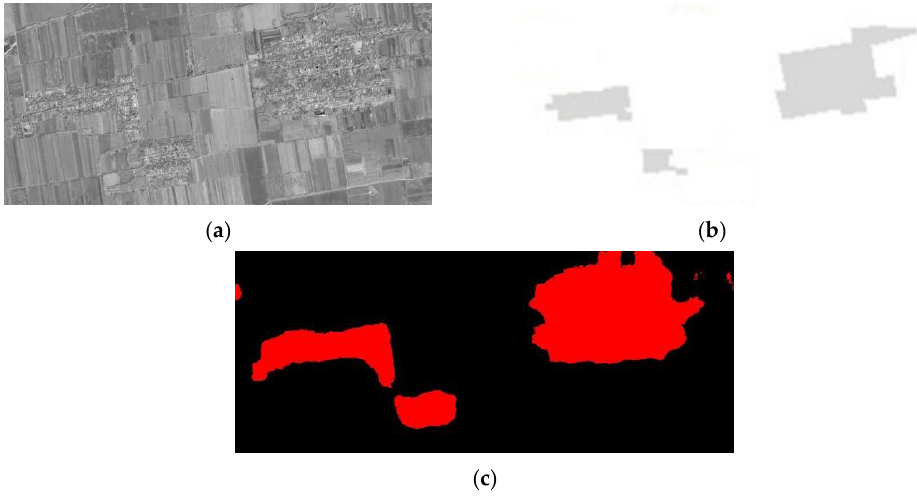
Figure 1. An example of residential area mapping based on images: ( a ) Original image; ( b ) the resi- dential area layer in topographic map; and ( c ) direct extraction results of residential areas.